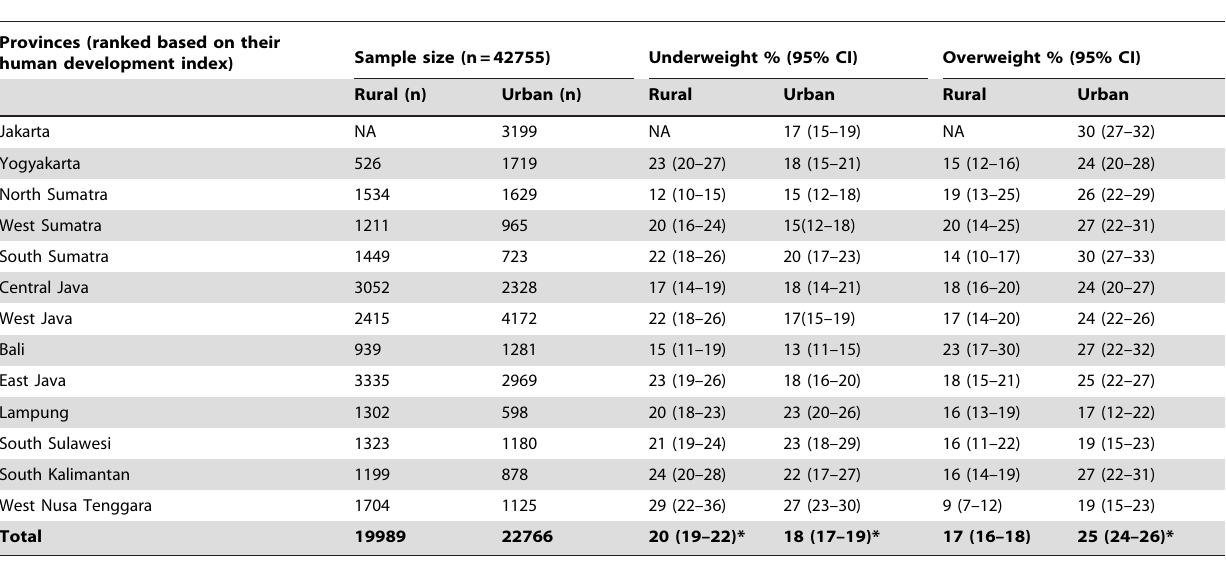
Table 1. Prevalence (and 95% confidence interval/CI) of underweight and overweight at the individual level in the 13 provinces of Indonesia in